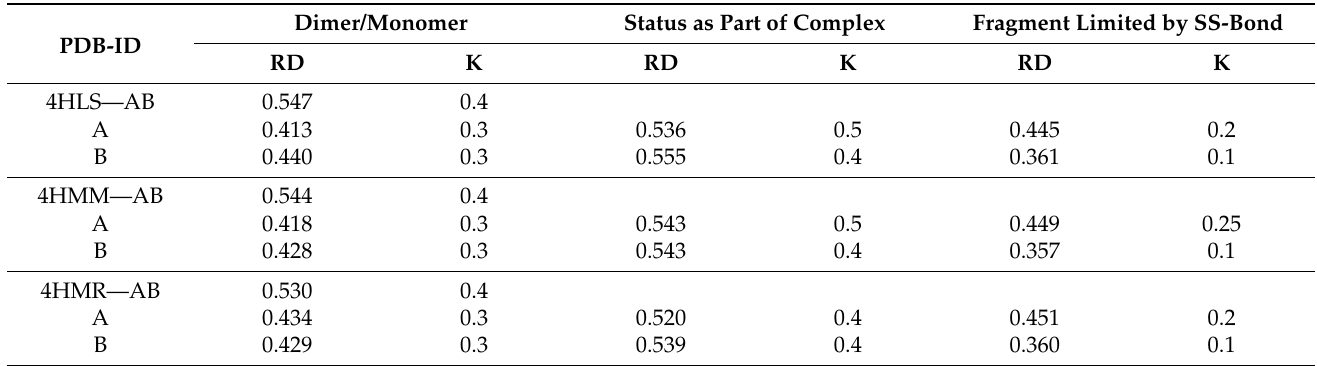
Table 3. Prion proteins for which their structure available in PDB are dimers.